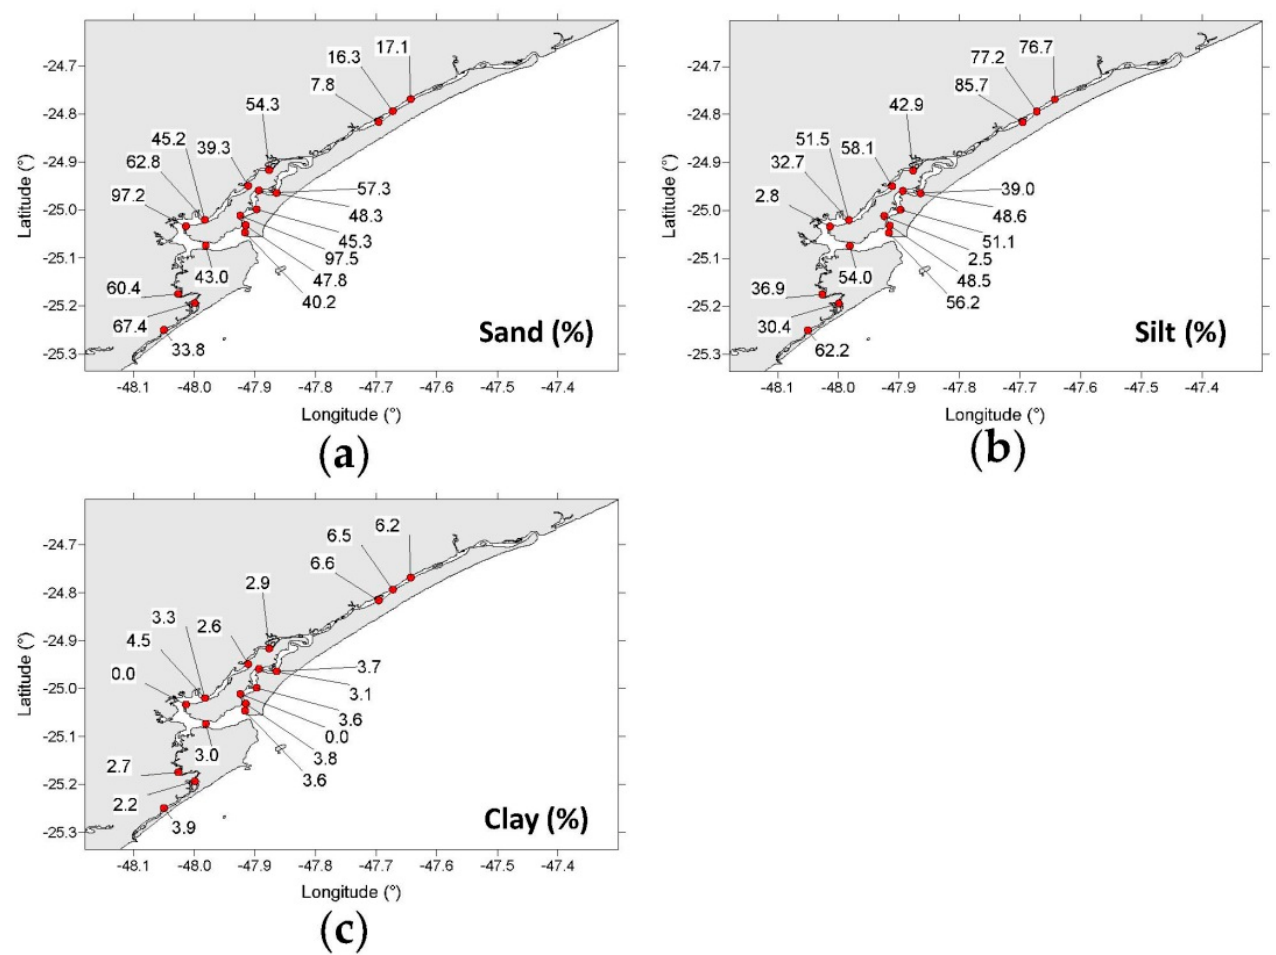
Figure 2. Percentage distribution of the three main grain size components: ( a ) Sand; ( b ) Silt; ( c ) Clay. The mean CaCO 3 content was 4.6%, ranging between 0.0% (to the west of Canan é ia Island) and 11.5% (Canan é ia inlet) (Figure 3a). TOC mean value was 1.7%, with maximum values close to the Canan é ia and Ararapira inlets (3.7 and 3.0%, respectively) and in Mar Pequeno (2.4–2.6%) (Figure 3b). TN mean value was 0.13% (Figure 3c). As observed in